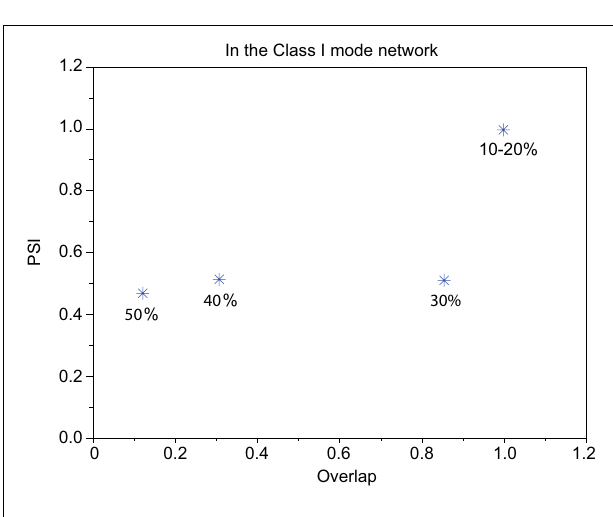
M2, M3, and M4 are overlaps between the state of the neurons and the stored pattern 1, 2, 3, and 4, respectively. Planes (F–J) show the synchronized properties when the input pattern contains from 10 to 50% errors.